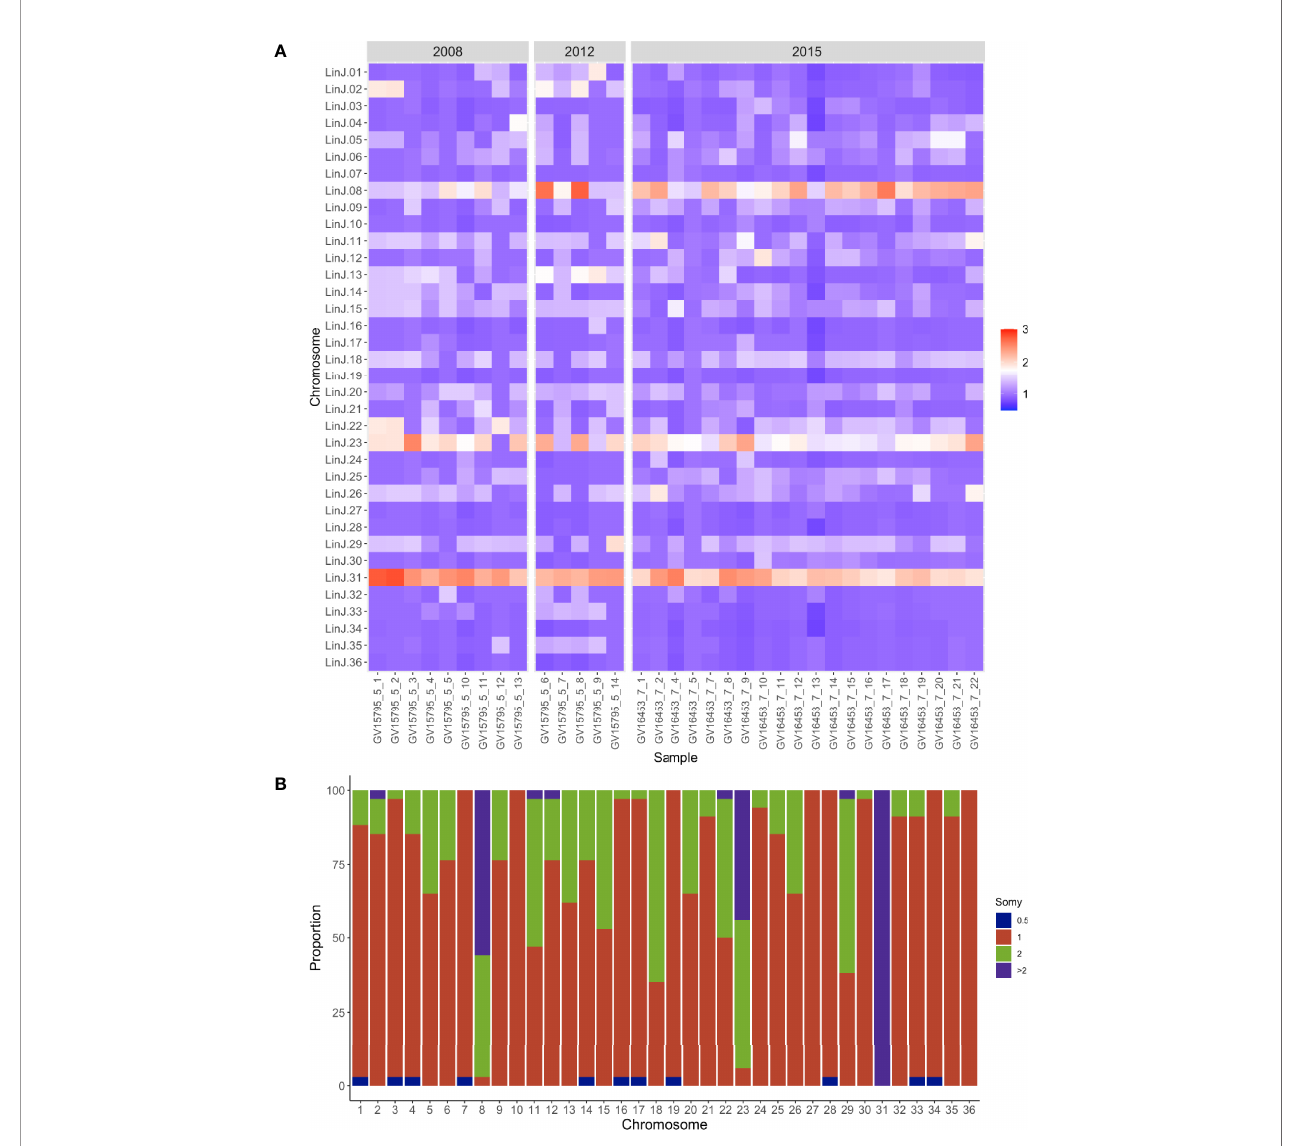
FIGURE 3 | Aneuploidy in the Governador Valadares L. (L.) infantum isolates. (A) This heat map shows copy number of the 36 chromosomes, the y-axis indicates the chromosome and the x-axis the isolate. Colors indicate disomic (1, blue scale), trisomic (1.5, light blue scale), tetrasomic (2, light red scale) and pentasomic (2.5, red scale) chromosomes. The color key shows the normalized chromosome read depth and the frequency. (B) This graph shows the distribution of chromosome copy number for each chromosome in the population. The y-axis denotes the proportion of isolates and the x-axis the respective chromosome. The color key shows the normalized chromosome read depth and the frequency (0.5 monosomic; 1 disomic; 2 tetrasomic; >2 more than